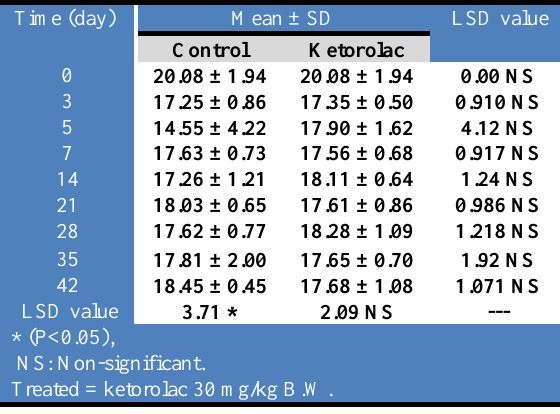
Table, 4: Shows MCH concentration (pg) values in control and ketorolac treated